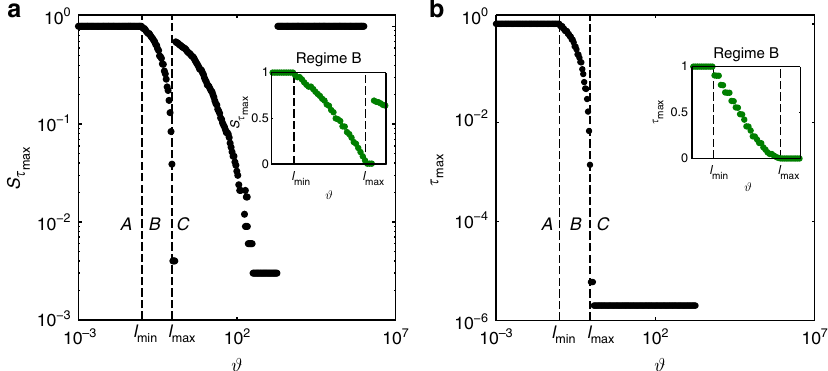
, and relative coreness, t max , versus the cost, W . ( a ) A decay in the size of the Figure 3 | Characteristic metrics of t -core decomposition. Core size, S t max core in regime B for increasing cost is shown. Core size increases again abruptly in the transition between regimes B and C as the pruning mechanism slows down. ( b ) Illuminates upon the comparison of the relative coreness of the core between a fully connected network in regime A and a core–periphery observed in regime B. The insets of both figures are blow-ups of regime B. The core of the network in regime B has a much lower coreness, which decays continuously with increasing cost until the network becomes a tree. Data are averages over 100